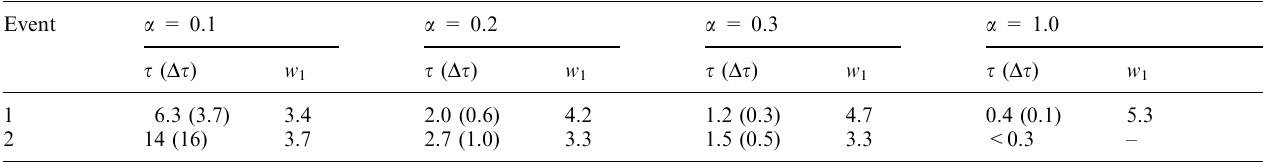
Table 2. Analytical results of the balance equation integration. The values of s and w given as a function of e(cid:129)ciency factor a . The absolute errors in s ( ds ) are derived from Eq. (11). All entries are in hours Event a = 0.1 a = 0.2